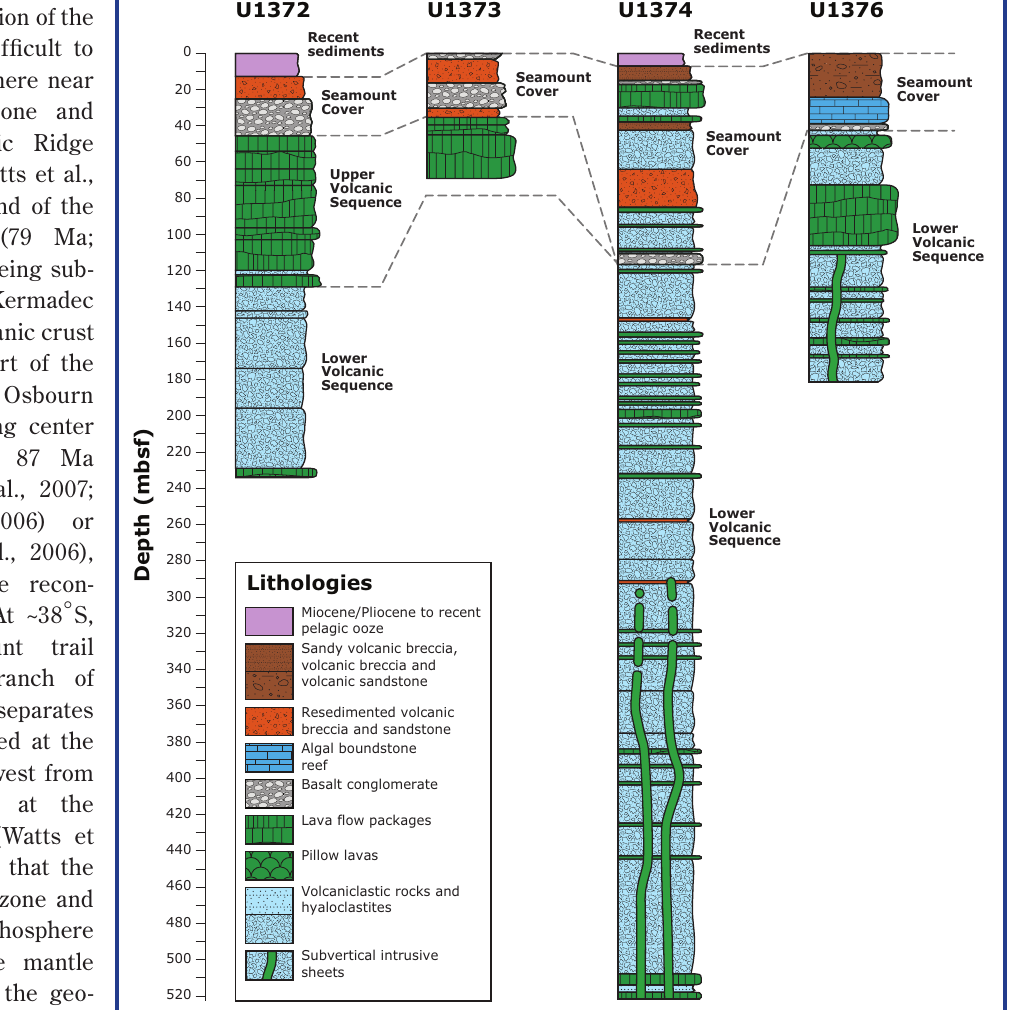
Figure 2. Stratigraphic summary of the four deepest IODP Exp. 330 drill sites. The drilled sequences of Sites U1372 (Canopus Guyot), U1373 and U1374 (Rigil Guyot), and U1376 (Burton Guyot) are displayed in a simplified fashion to emphasize the overall lithological construction of the Louisville seamounts. Four lithology groups are recognized, from young to old: (i) recent pelagic ooze; (ii) an older seamount sedimentary cover; (iii) an upper volcanic sequence dominated by massive lava flows and interlayered with volcaniclastics; and (iv) a lower volcanic sequence characterized principally by volcaniclastics and hyaloclastites, but interspersed with lava flows and subvertical dike intrusions. The large fraction of volcaniclastics in these sequences sets the Louisville seamount trail apart from the lava-flow-dominated Emperor seamounts (Duncan et al., 2006). Downhole data plots for Sites U1375 and U1377 are omitted because of the shallow penetration depths. Figure after Koppers et al.